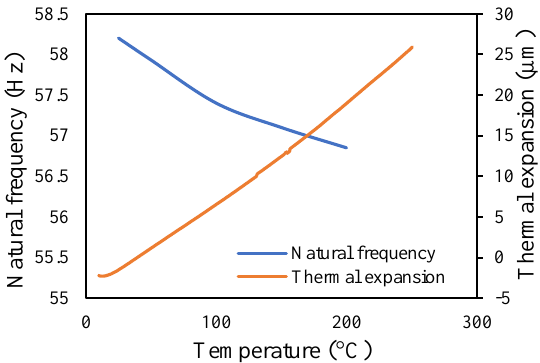
Figure 29. Thermal expansion and modal frequency at different